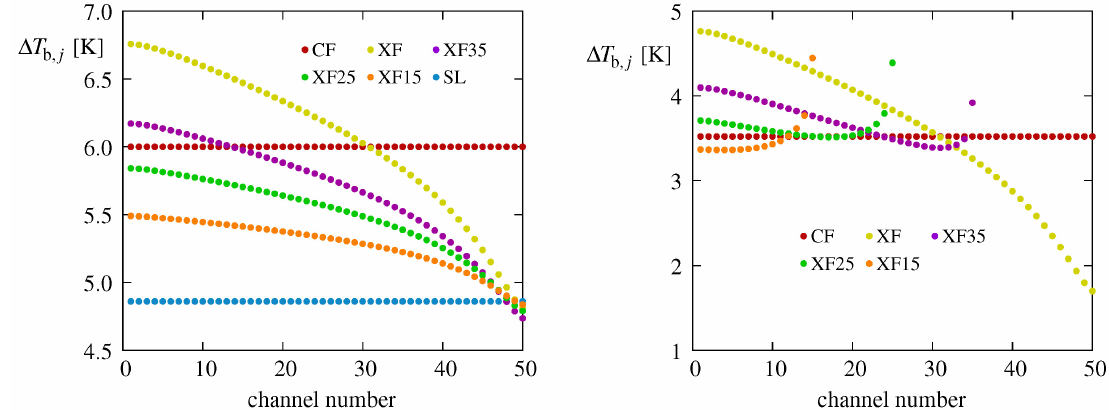
Figure 8. Microchannel outlet bulk temperatures in the bottom and top layers for ˙ V = 2.5 mL/s ( left : bottom layer; right : top layer).